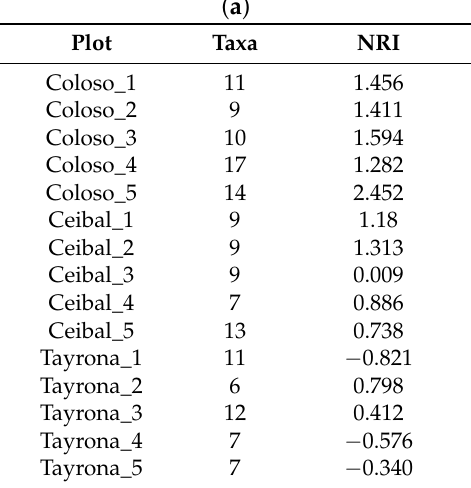
Table A3. ( a ) Results of phylogenic local community analyses from all the study plots using the regional species pool of all species occurring in the study as a reference for the null models. None of the NRI values except for Coloso_5 differed significantly from a random assemblage. ( b ) Results of the phylogenic community analyses using the site-specific termite pools as references. None of the NRI values differed significantly from a random